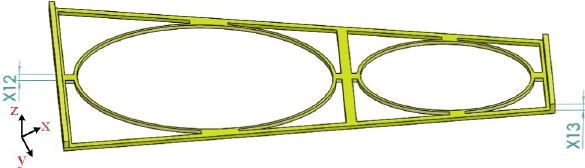
Figure 13. Schematic of the design variables of the main mirror support